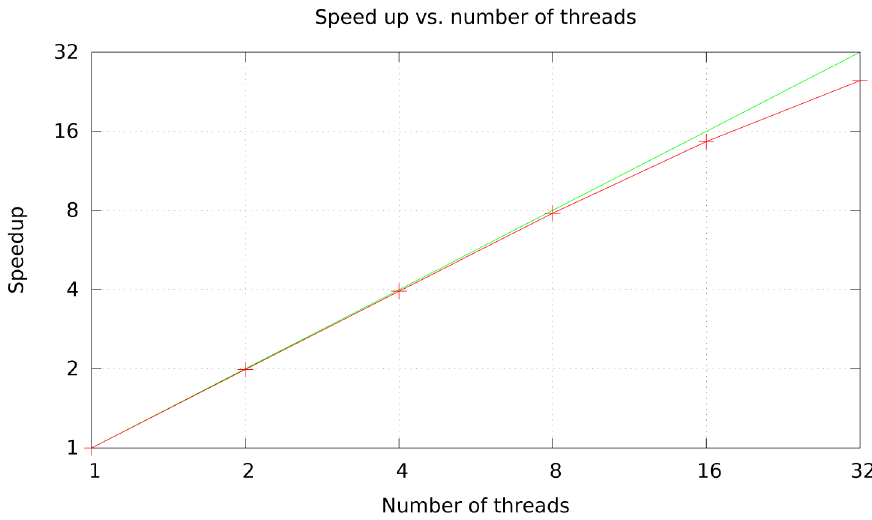
Fig 1. Scaling of nucmer4’s performance when aligning Illumina reads to the A. thaliana genome with 1–32 threads. All tests were run on a 32-core AMD Opteron computer.